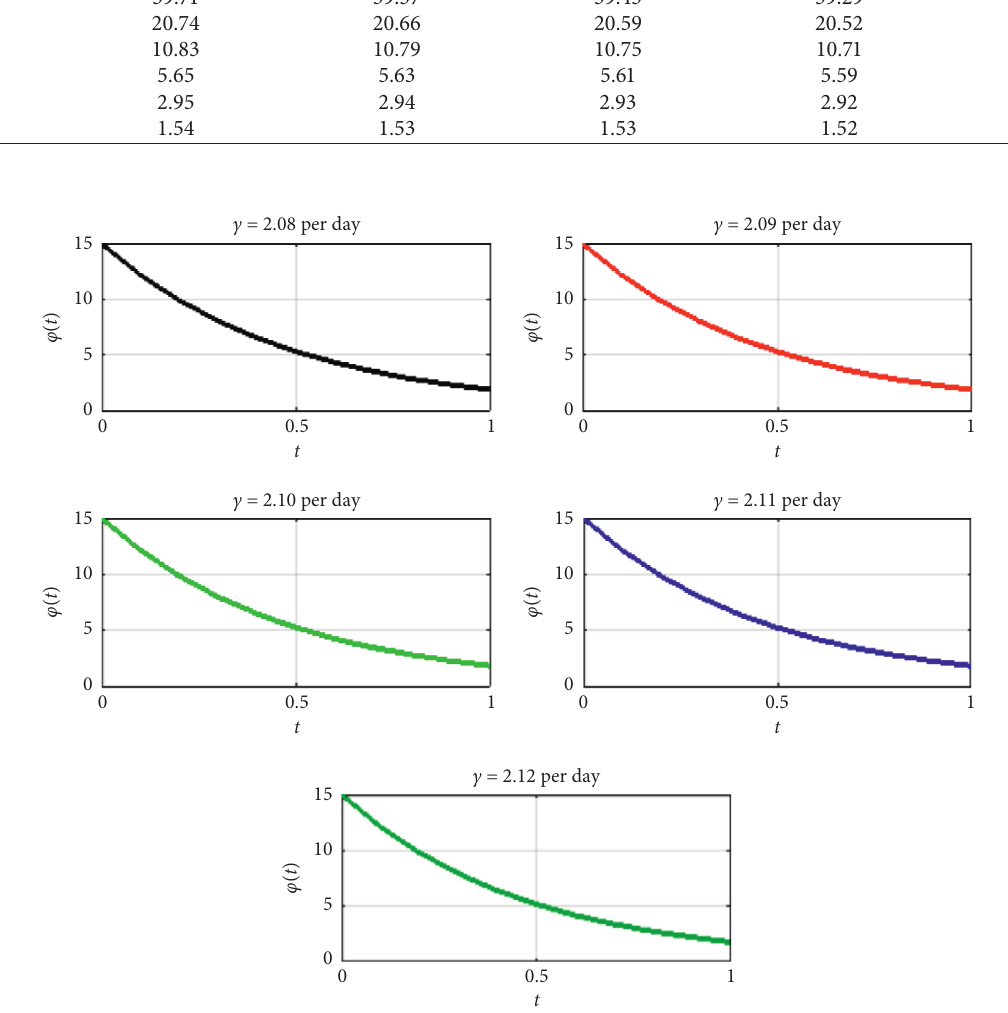
Figure 1: Concentration of viral particles in plasma φ for different values of time t and rate constant of viral particle clearance c with initial � concentration of viral particles in plasma φ 0